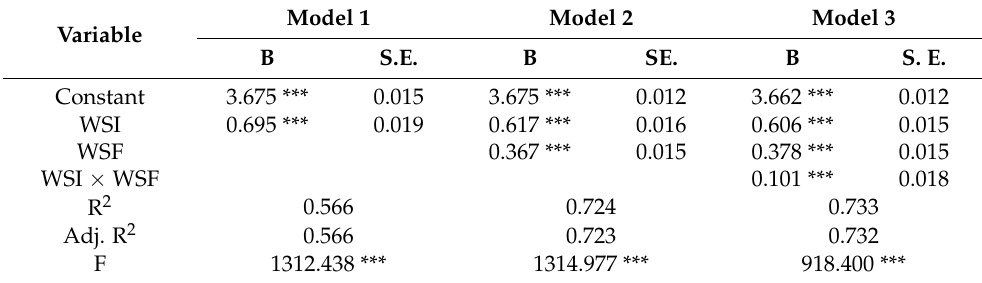
Table 6. Results of the test on the moderating effect of waste separation